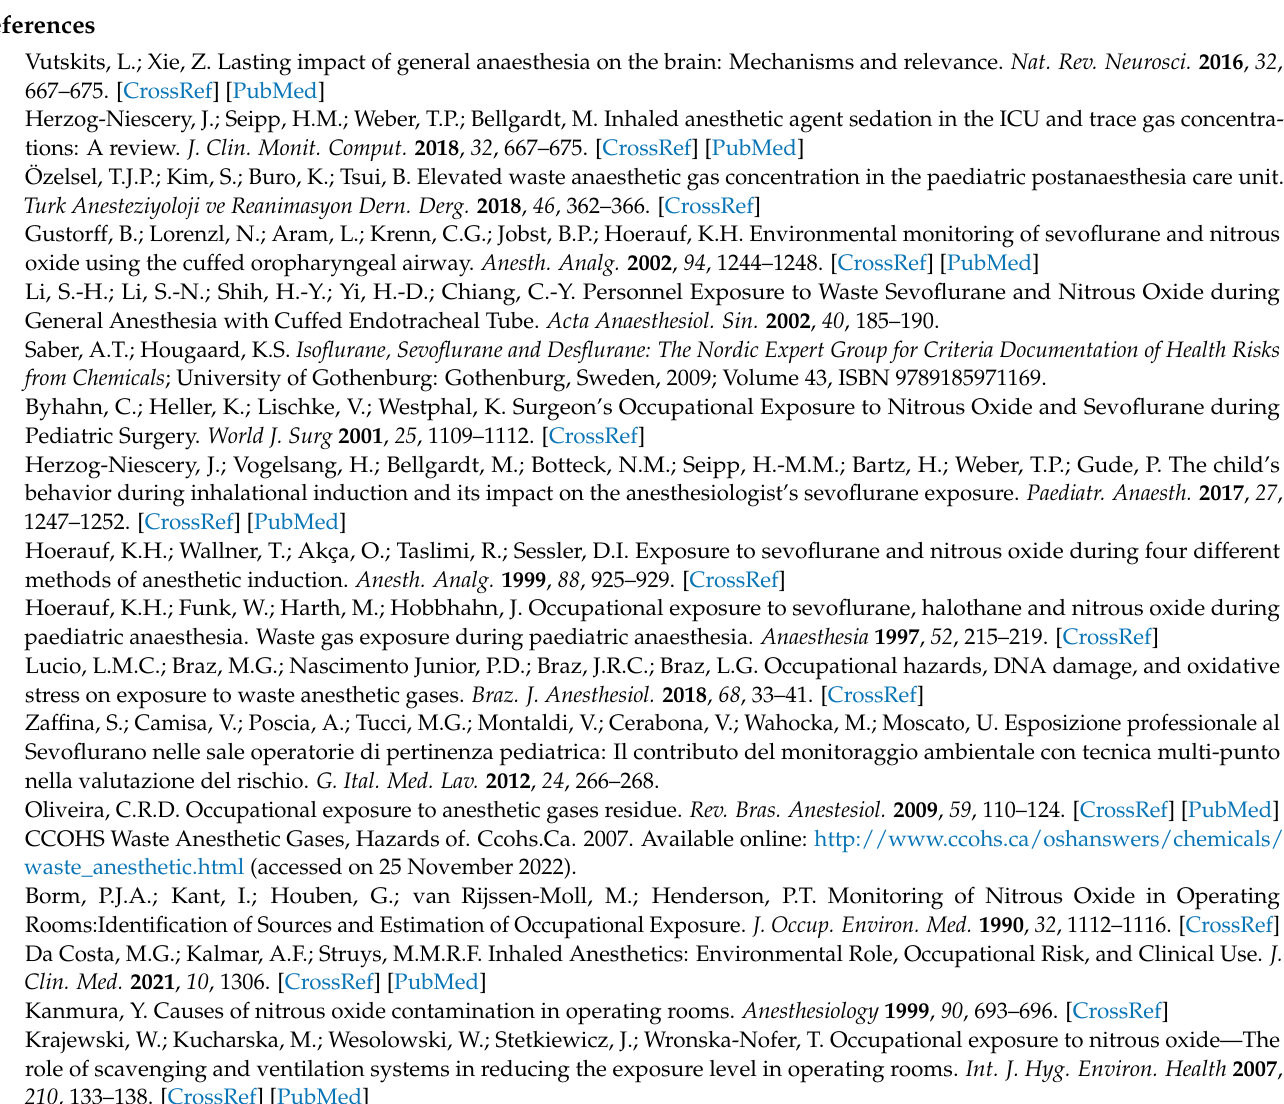
Table S5: Real-time samplers for anaesthetic gases present in the articles in